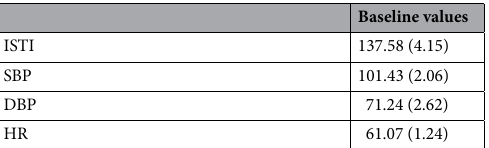
Table 1. Means and standard errors (in parentheses) baseline values of initial systolic time interval, systolic blood pressure, diastolic blood pressure and heart rate. ISTI initial systolic time interval (in ms), SBP systolic